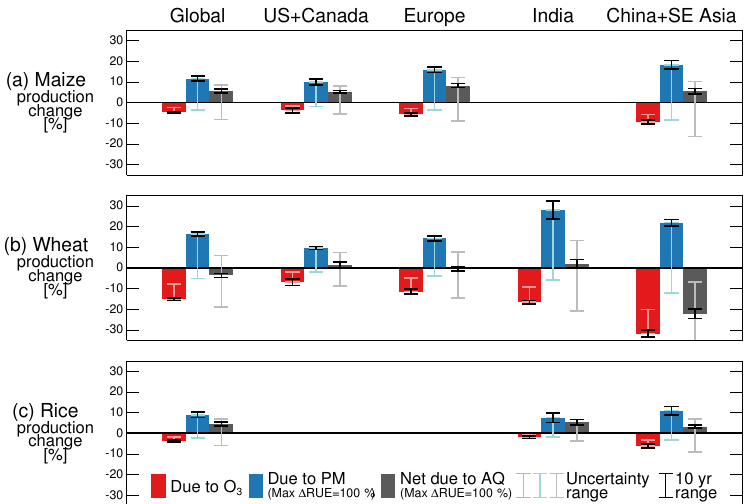
Figure 7. Regional relative change in crop production due to surface ozone (red bars), PM with max (cid:49) RUE = 100% (blue bars), and both ozone and PM (gray bars). Sampled to growing season ending in 2010 for (a) maize, (b) wheat, and (c) rice. Light red, light blue, and light gray lines indicate range of production from 0 to − 10ppb surface ozone concentration correction, from max (cid:49) RUE = 0% to max (cid:49) RUE = 100%, and from both effects, respectively. Black lines indicate range of production change over 10 years of variable meteorology. Regions with a base production lower than 5% of the global total are not shown. Relative change calculated from GAEZ 2010 base production adjusted for 2010 PM and ozone production